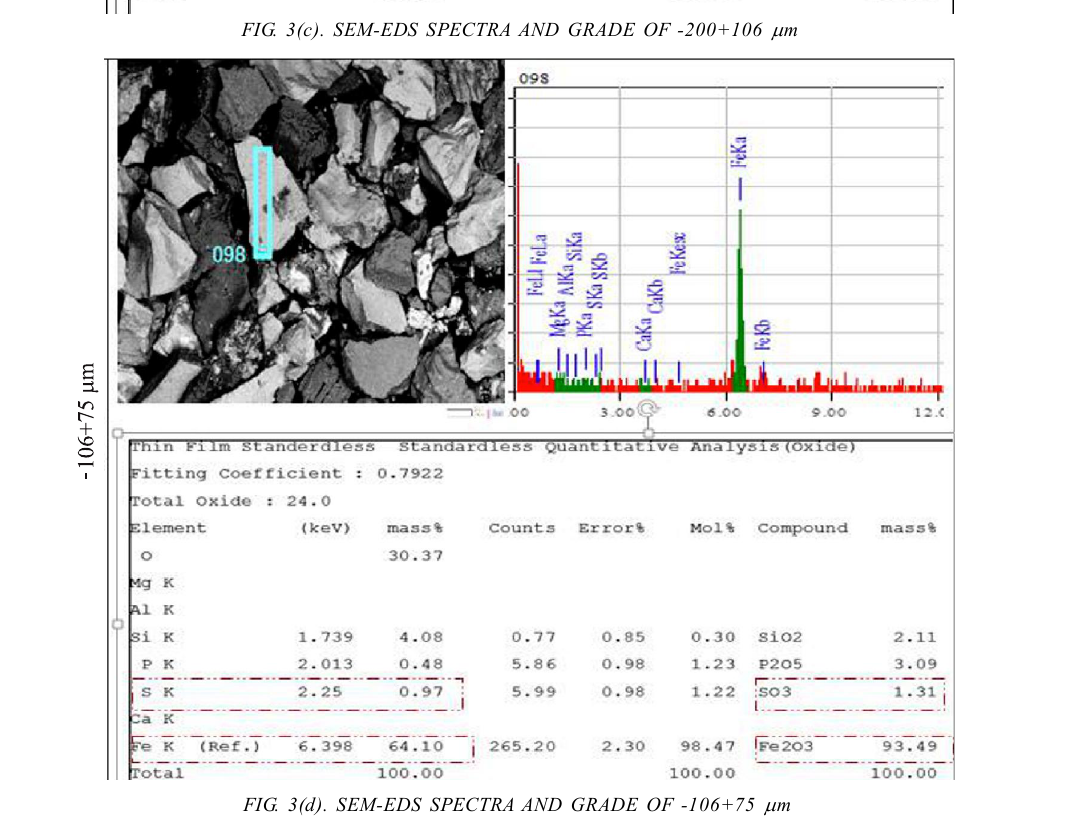
FIG. 3(c). SEM-EDS SPECTRA AND GRADE OF -200+106  m